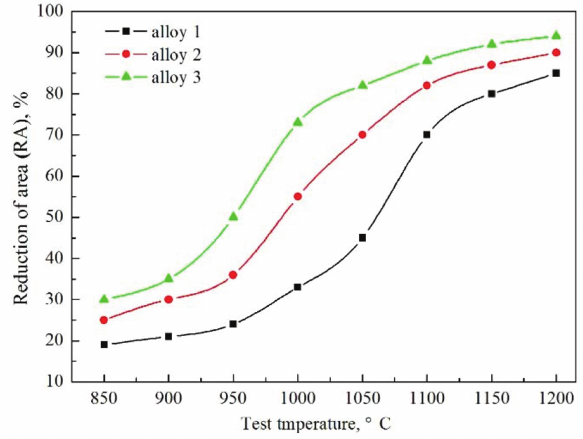
Figure 5: Hot ductility curves of tested